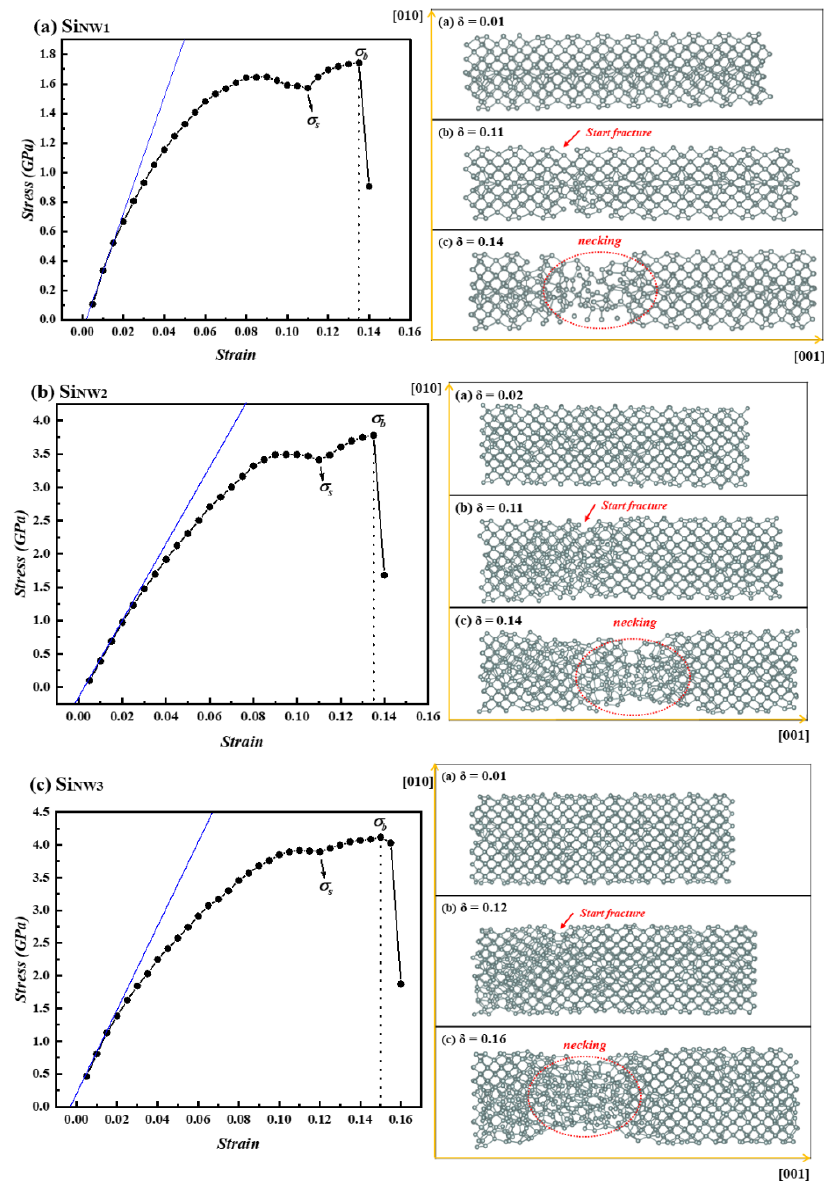
Figure 7. ( Left ) Stress–strain curves of silicon nanowires of various diameters at room temperatures; ( Right ) the structural evolution of nanowires: ( a ) SiNW1, ( b ) SiNW2, and ( c ) SiNW3.